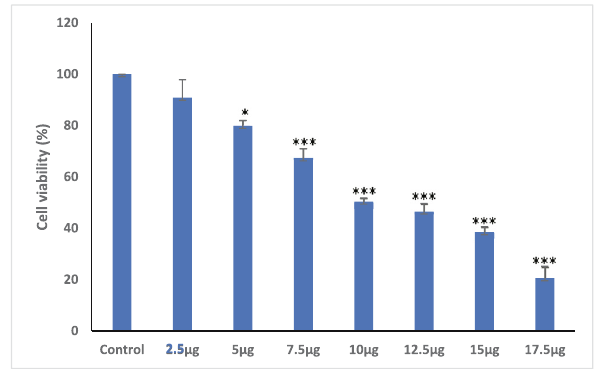
Figure 6: Dose - dependent decrease in the cell viability of MDA - MB - 231 cells treated with ZnO